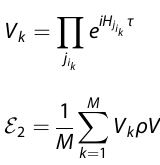
Error . The X-axis label of ( a ), ( d ) is 10